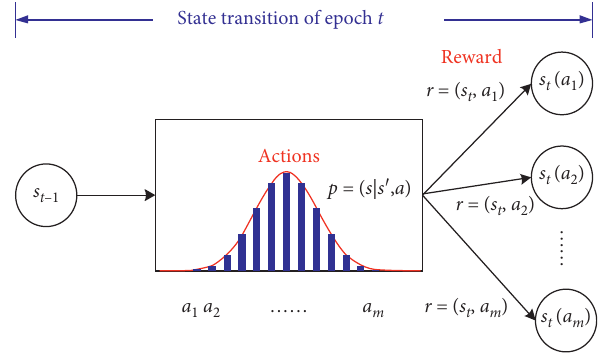
Figure 4: State transition